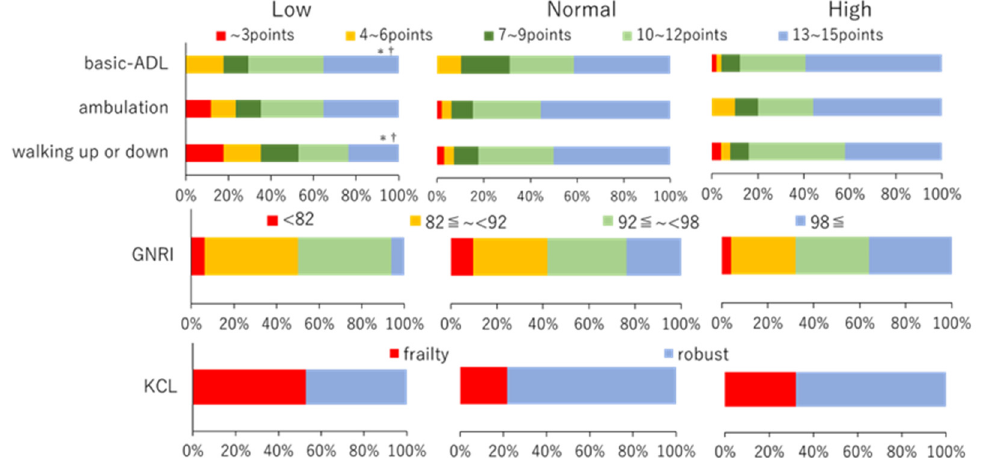
Figure 4. Percentage of ADL difficulty, Geriatric Nutritional Risk Index (GNRI), and Kihon check list (KCL) by classification. The basic ADL is shown in the upper panel. Red, 3 points; orange, 4–6 points; green, 7–9 points; yellow/green, 10–12 points; blue, 13–15 points. GNRI is depicted in the middle panel. Red, severe risk (<82); orange, moderate risk (82–92); yellow/green, mild risk (92–98); blue, without risk ( ≥ 98). The KCL is represented in the lower panel. Red, frail; blue, robust. *, vs. the Normal group, p < 0.05; † , vs. the High group, p < 0.05.